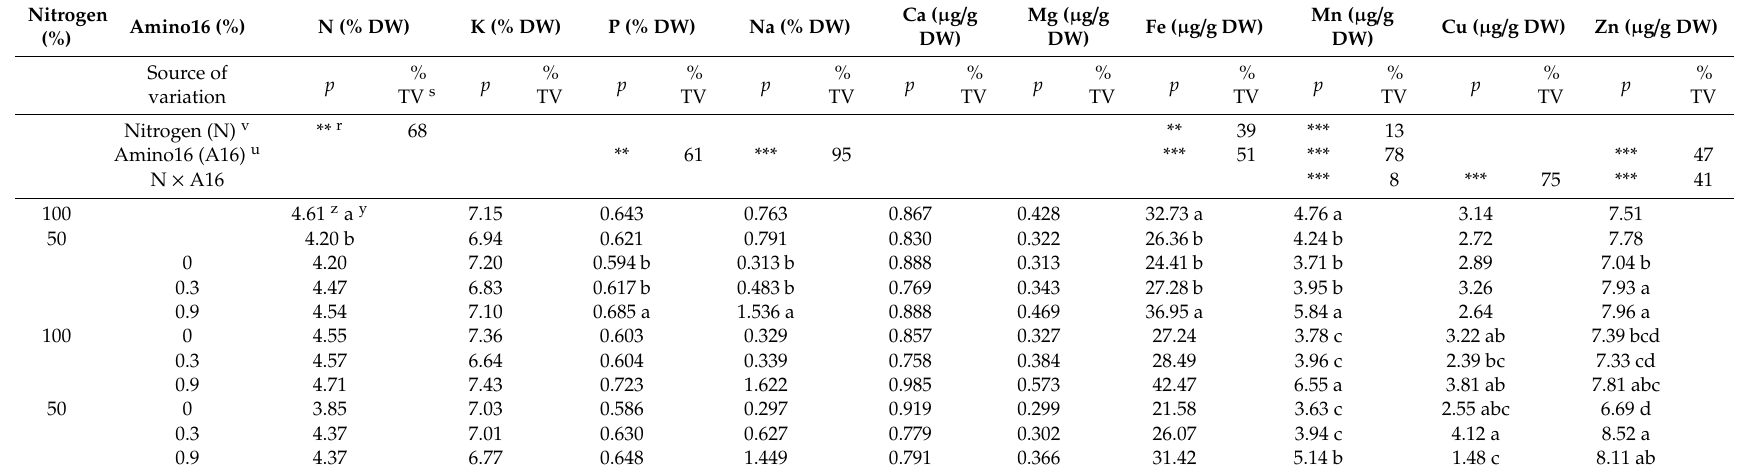
Table 3. Analysis of variance and mean comparison of mineral (N, K, P, Na, Ca, Mg, Fe, Mn, Cu, and Zn) content of green baby lettuce grown in 131 (100%)